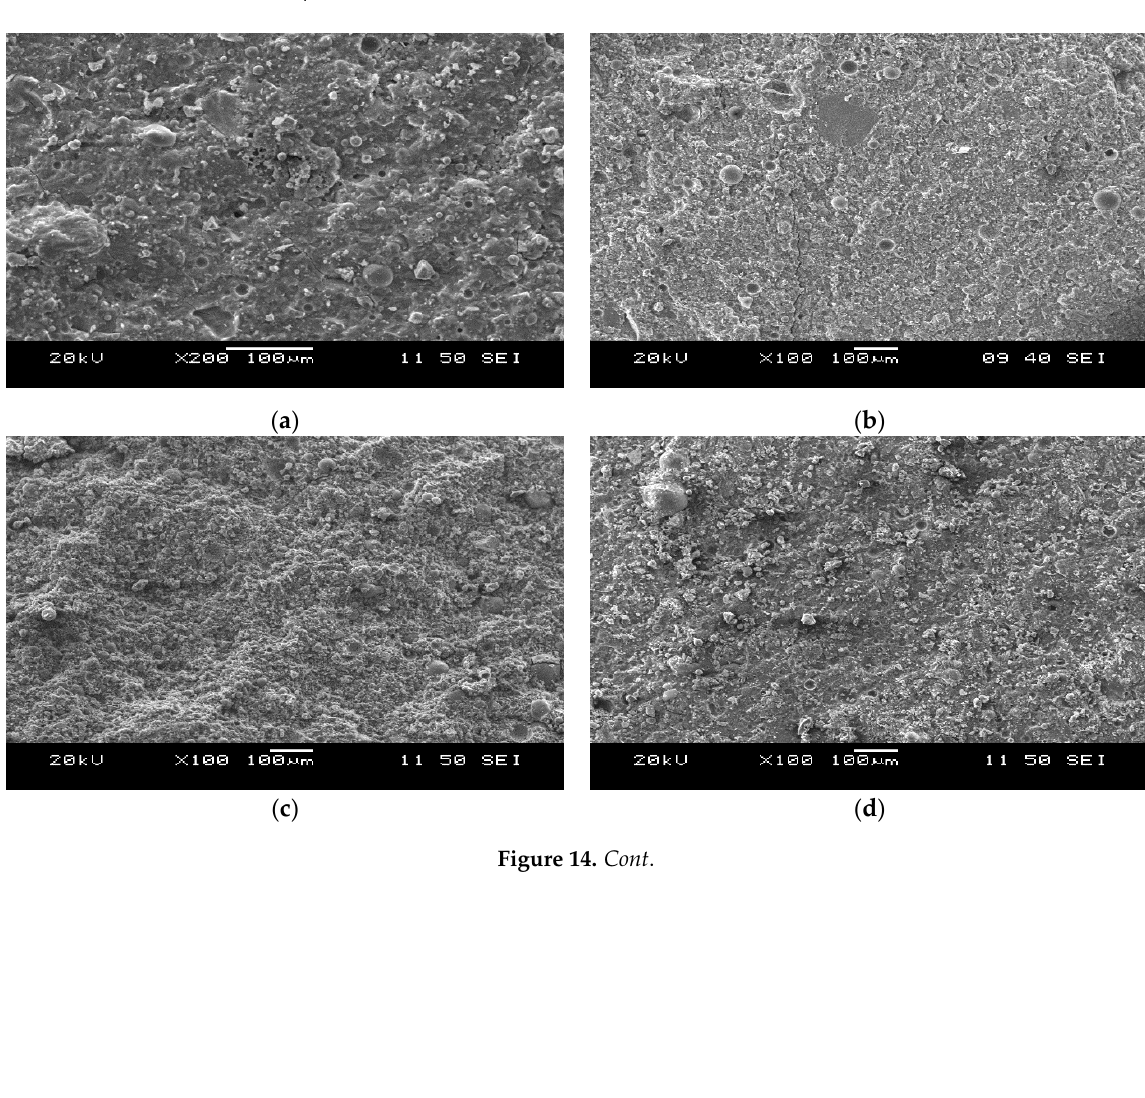
Table 4. Length and mass change of binders without and with fibers in ambient curing